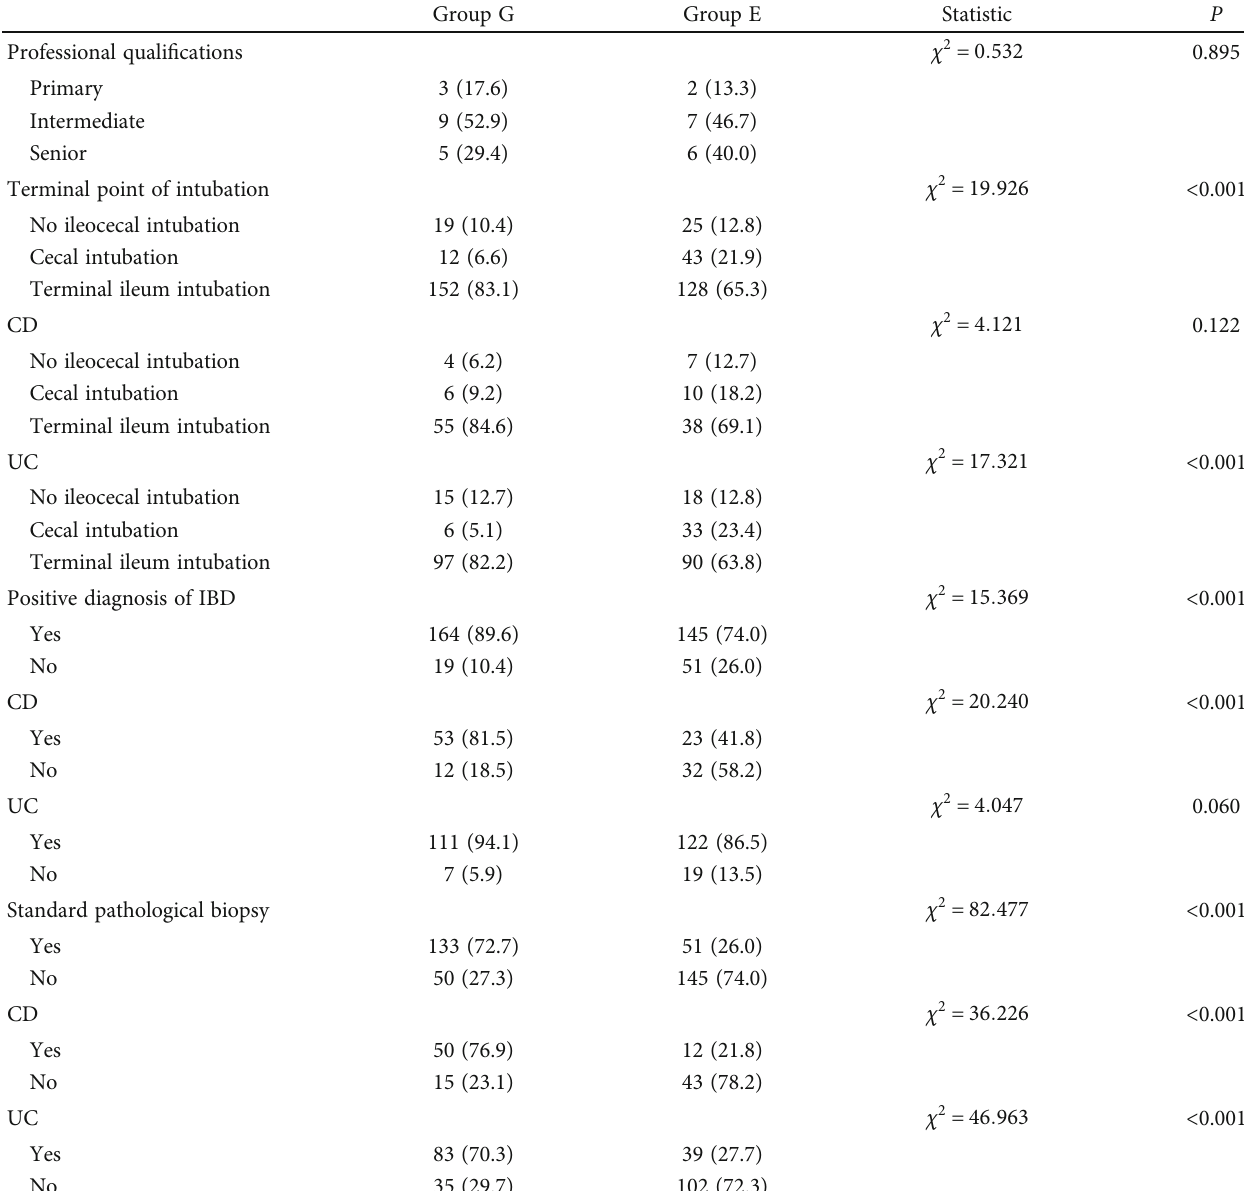
Table 2: Comparison of professional quali fi cations and patient outcomes between group G and group E. Group